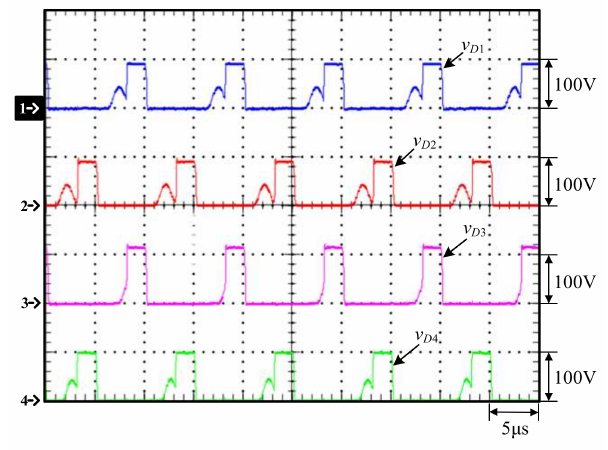
Figure 28. Measured waveforms relevant to 25% of the rated load: (1) v D 1 ; (2) v D 2 ; (3) v D 3 ; (4) v D 4 .